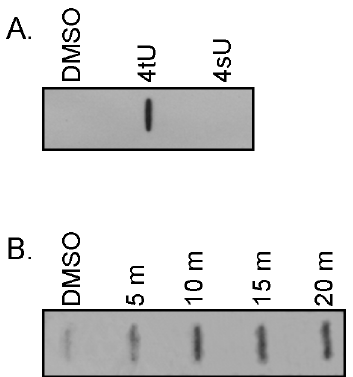
Figure 1. Incorporation of 4sU and 4tU into K.brevis RNA. A. Slot blots of biotinylated total RNA (1 m g) show that K. brevis